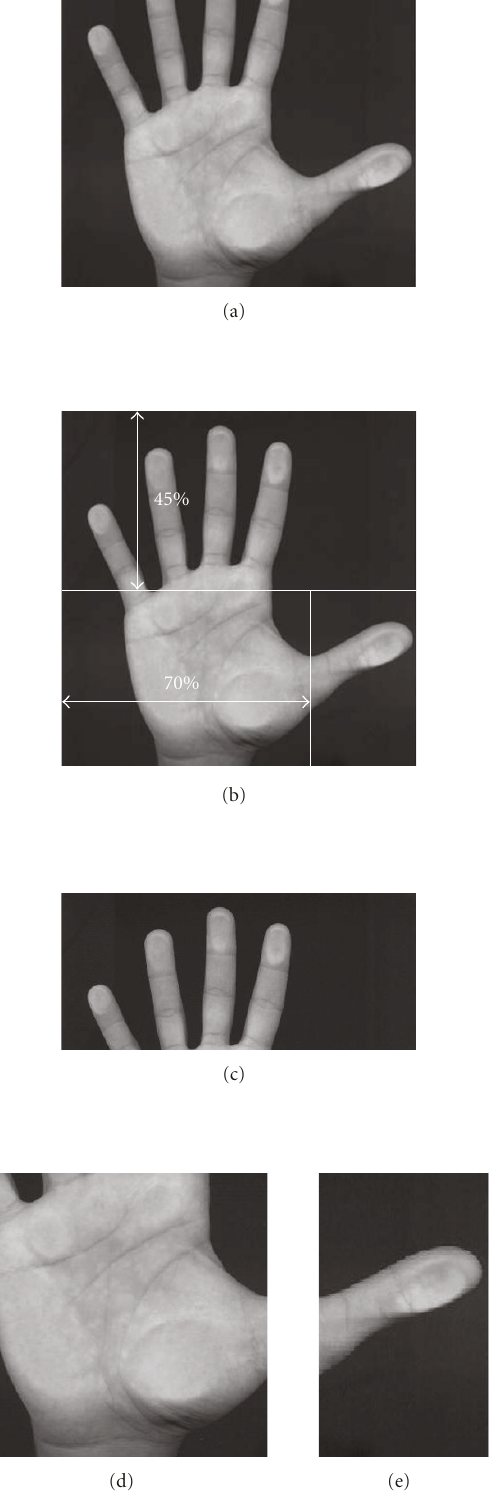
Figure 1: (a) original image. (b) original image with regions of in- terest marked. (c) “four-fingers” subimage. (d) “palm” subimage. (e) “thumb” subimage.